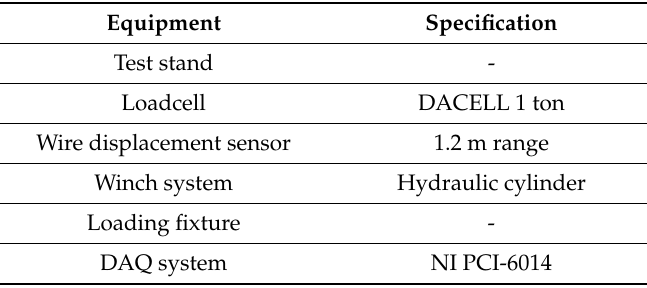
Figure 13. The static structural testing equipment configuration. Table 5. The equipment list for the static structural testing. Equipment